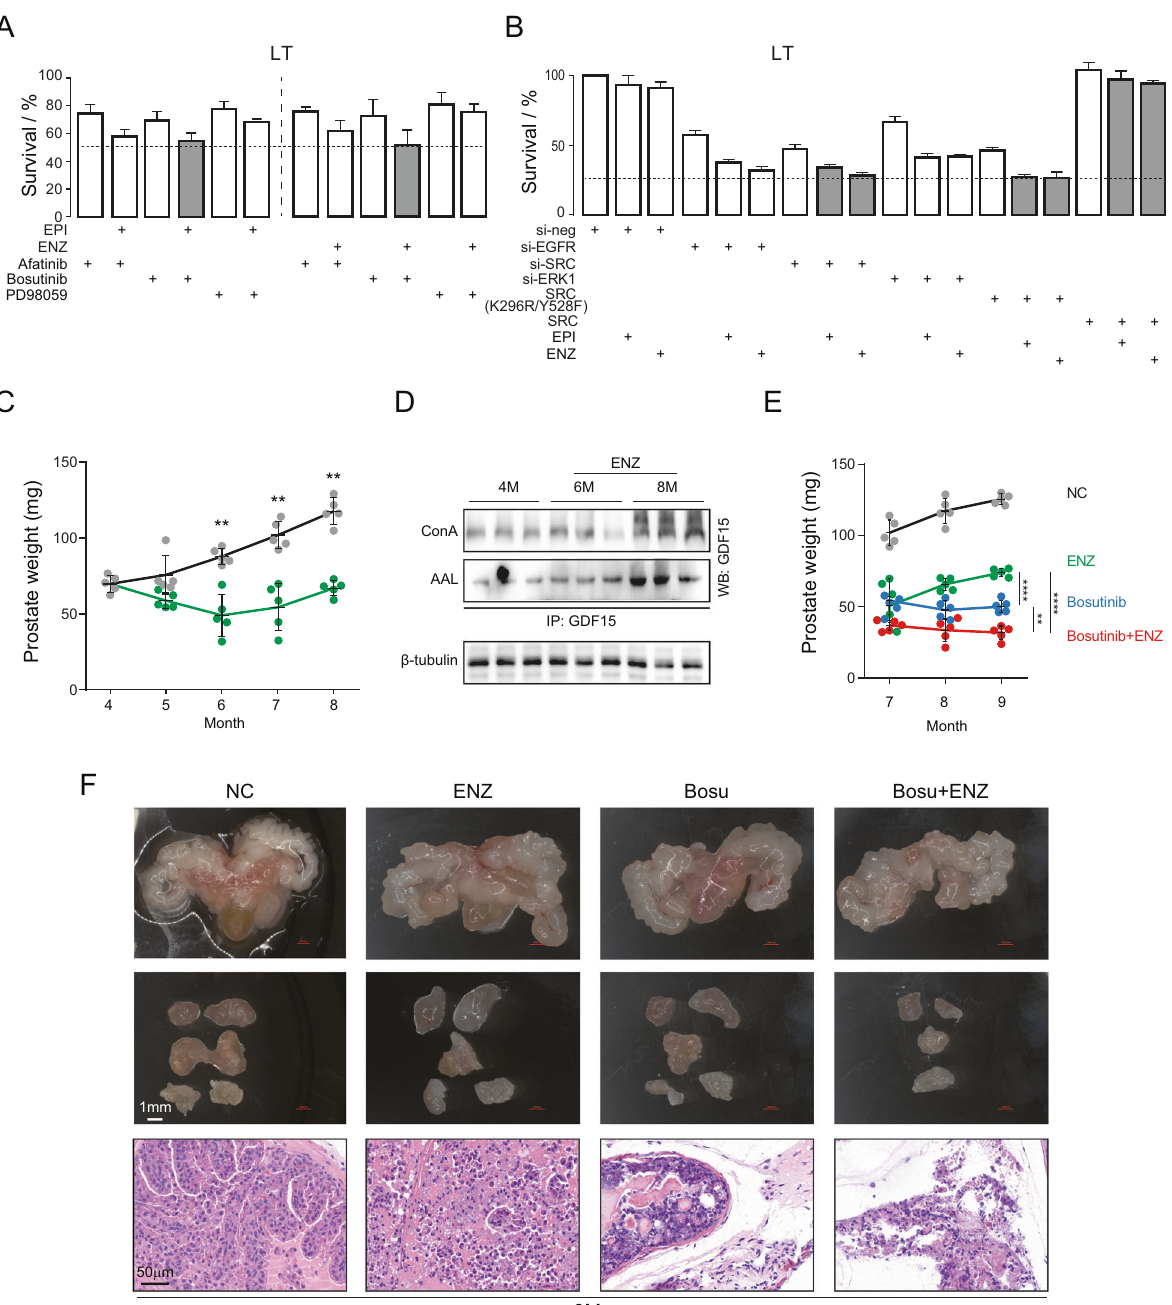
Fig. 6 SRC/AR inhibition signi fi cantly reduces tumor growth in castrated mice. A LT cells were treated with Afatinib (EGFR inhibitor), Bosutinib (SRC inhibitor), and PD98059 (ERK inhibitor) or in combination with EPI or ENZ. B LT cells were treated with siRNAs (si-neg, si-EGFR, si-SRC, and si-ERK1), dominant negative SRC (DNsrc), and overexpression SRC or in combination with EPI or ENZ. Survival rates are shown. Error bars indicate mean ± std of biological triplicates. C Prostate weights in NC and ENZ treatment groups were shown in graph. 5 mice per group. Student ’ s t -test, * p < 0.05. D GDF15 was immunoprecipitated and then levels of mannose and fucose were quanti fi ed with ConA and AAL antibodies. β -tubulin protein was employed as input control. E Prostate weight was showed in graph. n = 5 mice per group. Student ’ s t - test, * p < 0.05. F Representative images of mouse prostate glands (up panel), prostate lobes (mid panel), and histopathological sections from NC, ENZ, Bosu, and Bosu + ENZ groups. NC negative control, ENZ Enzalutamide treatment, Bosu Bosutinib treatment, Bosu + ENZ, Bosutinib and Enzalutamide combined treatment. Data are expressed as mean ± std. of biological Functional annotation and enrichment analysis annotated by UniProt-GOA database, InterProScan (https://www.ebi.ac.uk/ Gene Ontology (GO) annotation glycoproteome was derived from the interpro/about/interproscan) would be used to annotated protein ’ s GO UniProt-GOA database (https://www.uniprot.org/uniprot/A0A178W639). functional based on protein sequence alignment method. Then proteins Firstly, identi fi ed protein IDs were converted to UniProt ID and then were classi fi ed by Gene Ontology annotation based on three categories: mapped to GO IDs by protein ID. If some identi fi ed proteins were not biological process, cellular component, and molecular function. For